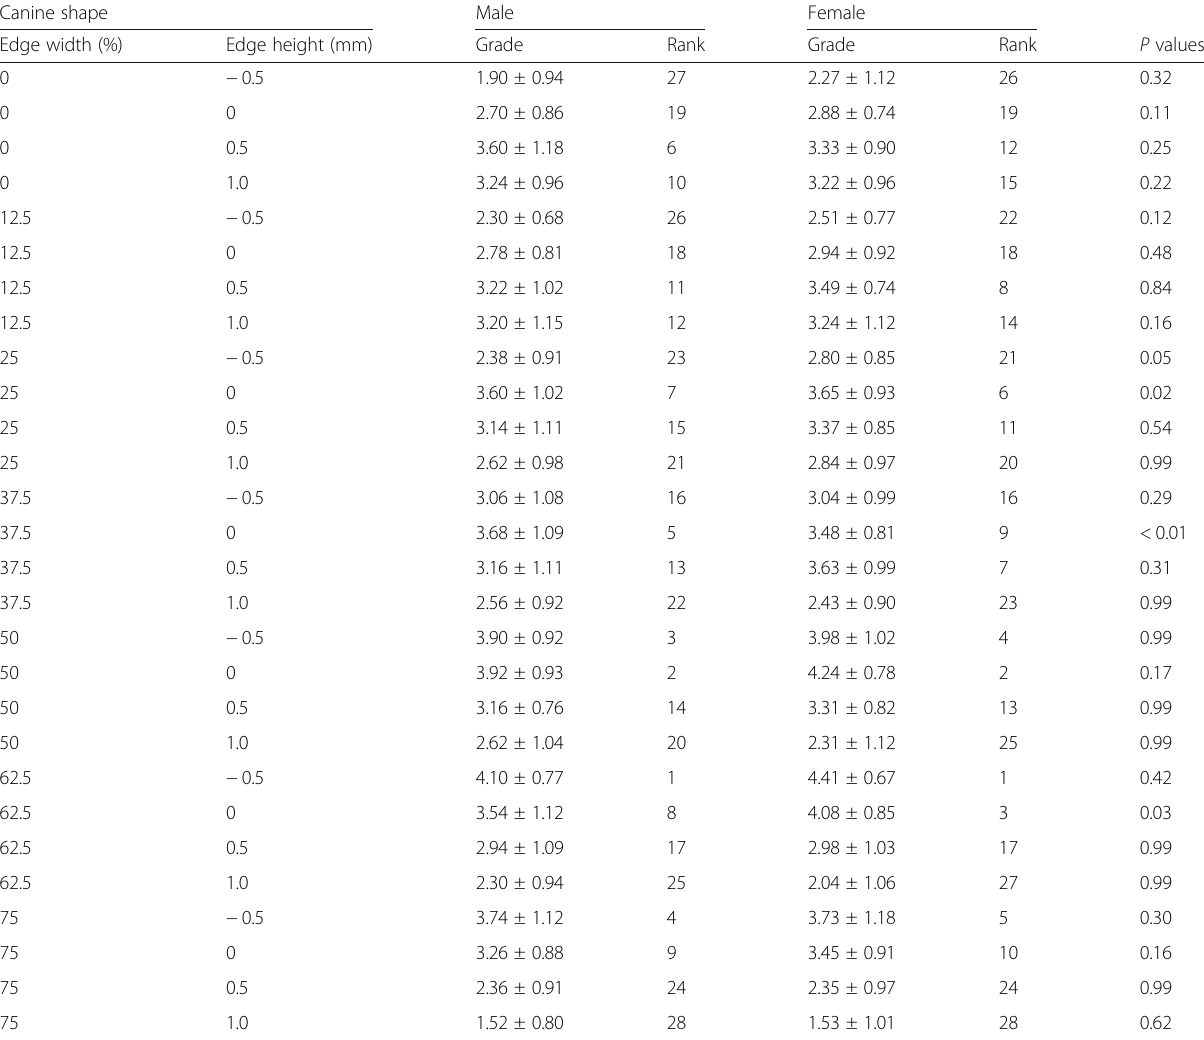
Table 4 Esthetic grade (mean ± standard deviation) and rank on the canine shape by the male and female observers. The P values were based on the chi-square and Fisher ’ s exact tests between male and female observers ’ grades Canine shape